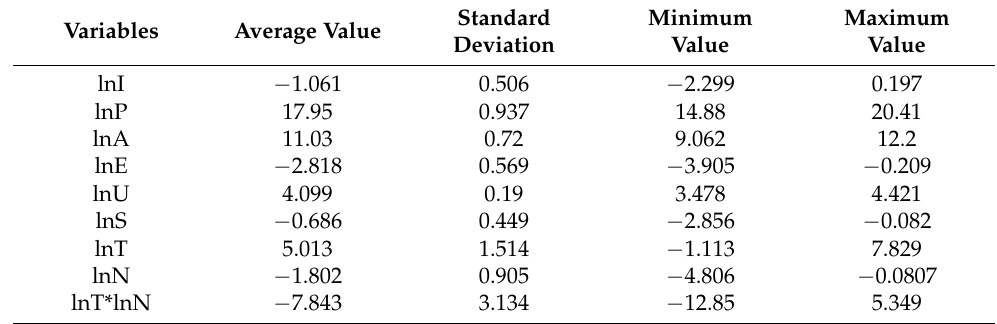
Table 3. Descriptive statistics of the variables.